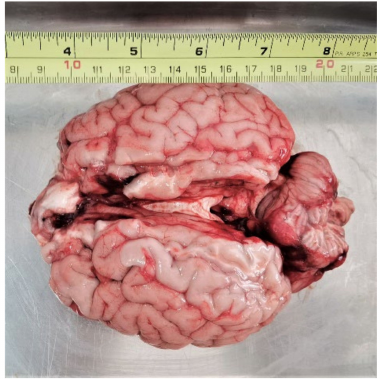
Figure 1. Bovine brain